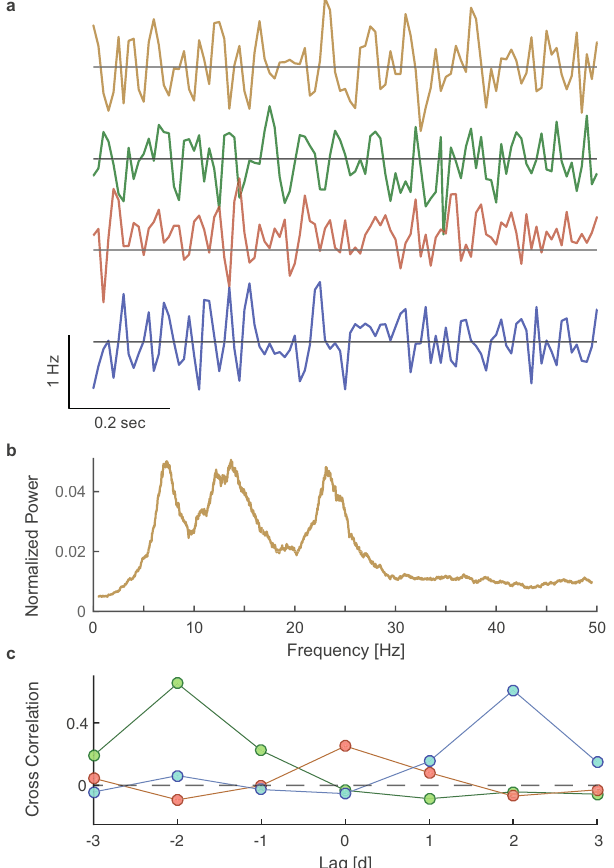
Figure 4. Analytical analysis of a network of networks, with 2000 neurons in each sub-network, color coded according to Fig. 3. ( a ) A typical sample of the activity, R(i) , of the four sub-networks. ( b ) The smoothed power spectrum (convoluted with rect(f/1 Hz) ) of the orange sub-network activity, over 210 seconds (first 10 seconds are neglected), illustrating peaks around 8, 12.5 and 25 Hz. ( c ) The cross-correlations between the activities of the orange sub-network and the other sub-networks (color coded) over 200 seconds as in ( b